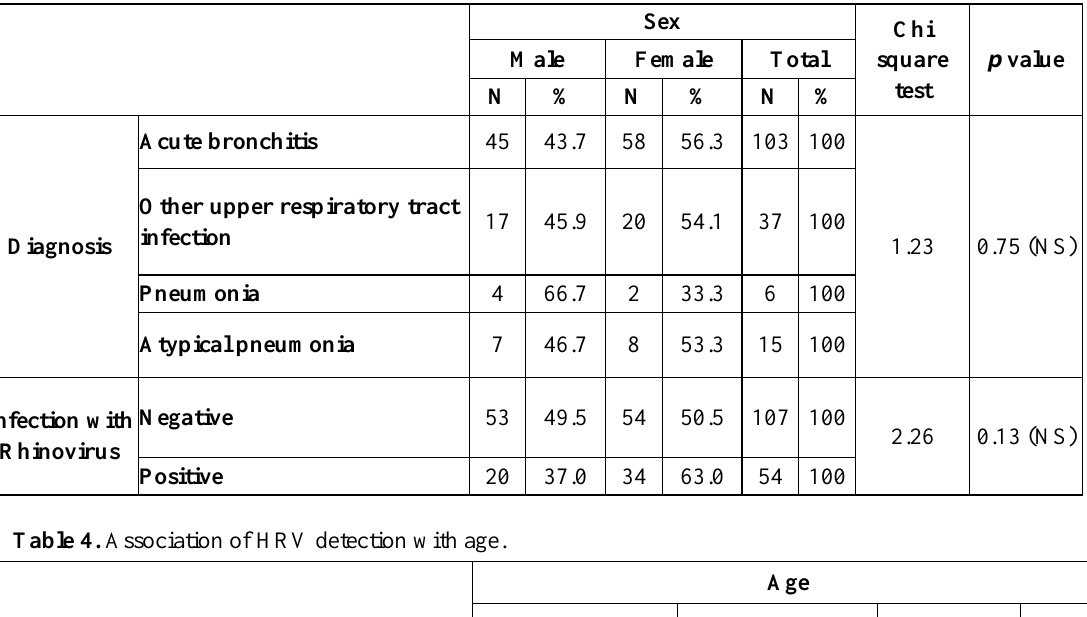
Table 3. Relation between gender with clinical diagnosis and HRV detected.